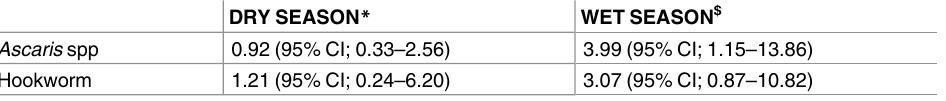
Table 3. Odds of infection with Ascaris spp and hookworm for farmersinvolved in wastewater irriga- tion compared with a control group in Kumasi,